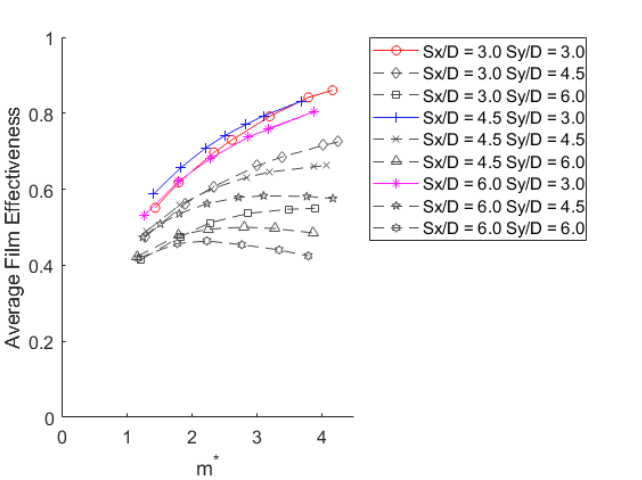
Figure 10. Experimental overall film effectiveness against non-dimensional mass flow ( m ∗ ). Geome- tries with S y / D = 3.0 are highlighted and have the highest averaged film protection, illustrating the benefits associated with low spanwise film